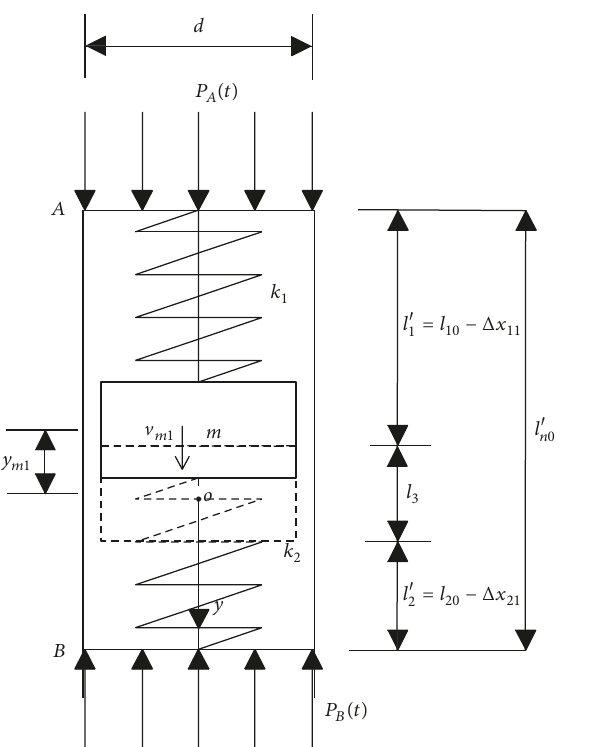
Figure 7: Initial state of the fixed-length